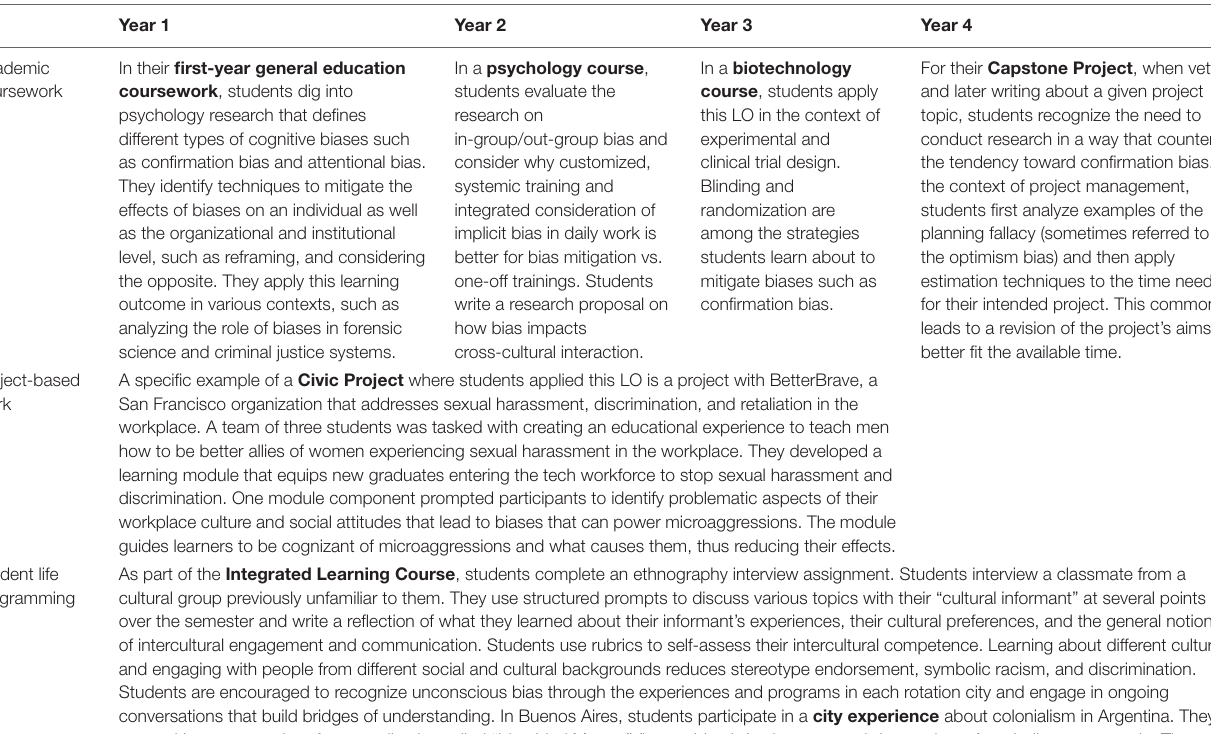
TABLE 4 | Integration of use and assessment of #biasmitigation across Students’ 4-year